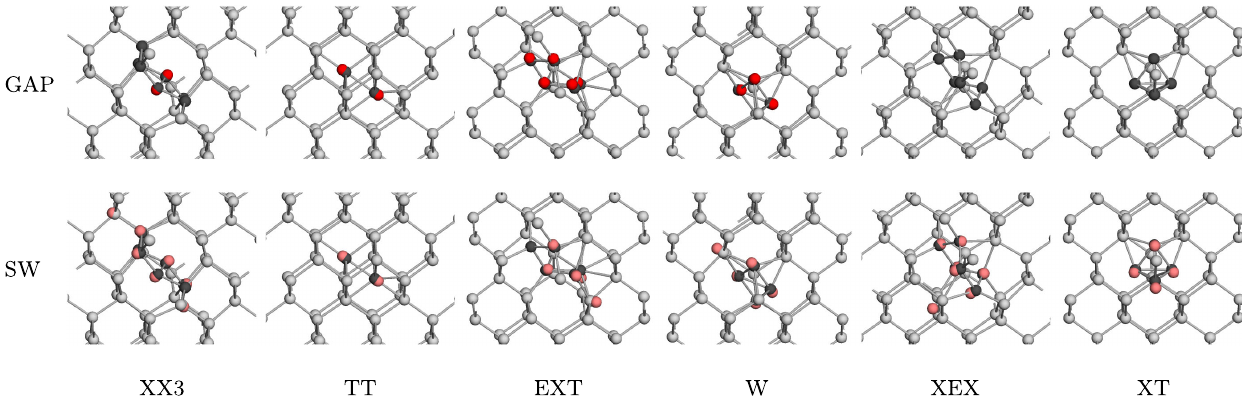
FIG. 27. Visualization of the atomic configurations of the relaxed di-interstitial structures with the GAP (top row) and Stillinger-Weber (bottom row). Dark gray spheres show reference DFT-relaxed positions of defect atoms (those that are significantly different from perfect lattice position or topology), light gray spheres show reference DFT-relaxed positions of other atoms, and colored spheres show interatomic-potential-relaxed positions of defect atoms that are more than 0.1 Å from the corresponding DFT atom